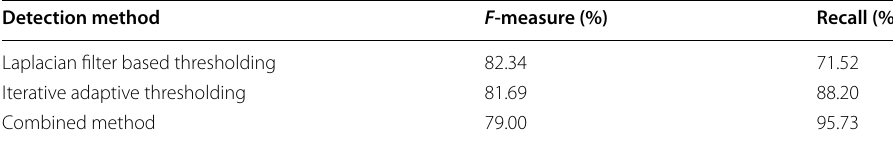
Table 1 Evaluation of interference detection methods